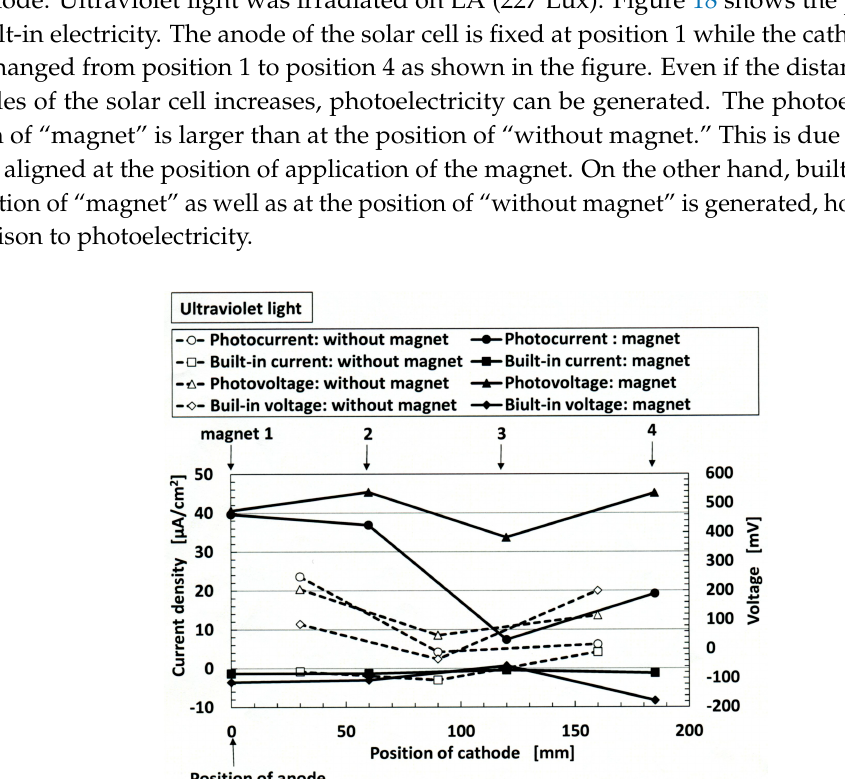
Figure 18. Change in photoelectricity and built-in electricity under ultraviolet irradiation on the position of the cathode of the solar cell for wet-type MCF rubber solar cell electrolytically polymerized under a magnetic field with ruthenium complex dye and electrolyte KI + I 2 : “without magnet” indicates the position between the regions influenced by the permanent magnet at electrolytic polymerization; “with magnet” represents the position influenced by the permanent magnet at electrolytic polymerization. In the figure, positions 1–4 for the applied magnet at electrolytic polymerization are also